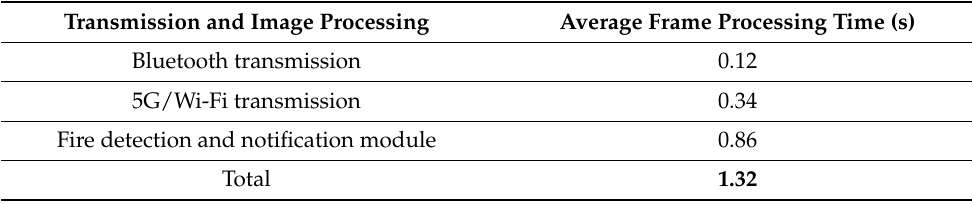
Table 9. Average frame processing time (in seconds) for each